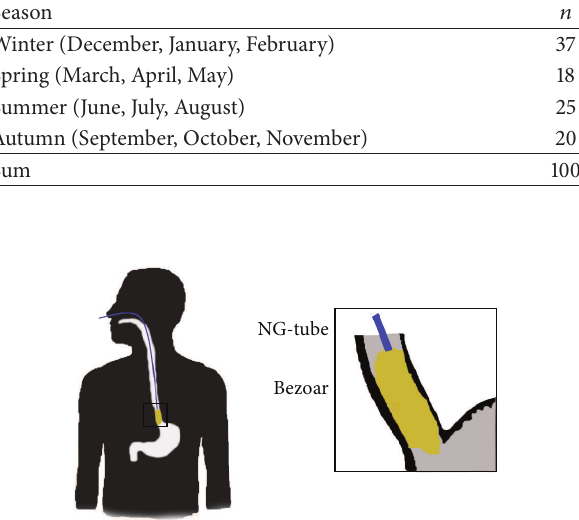
Figure 1: Illustration of tube placement for administration of the dissolution